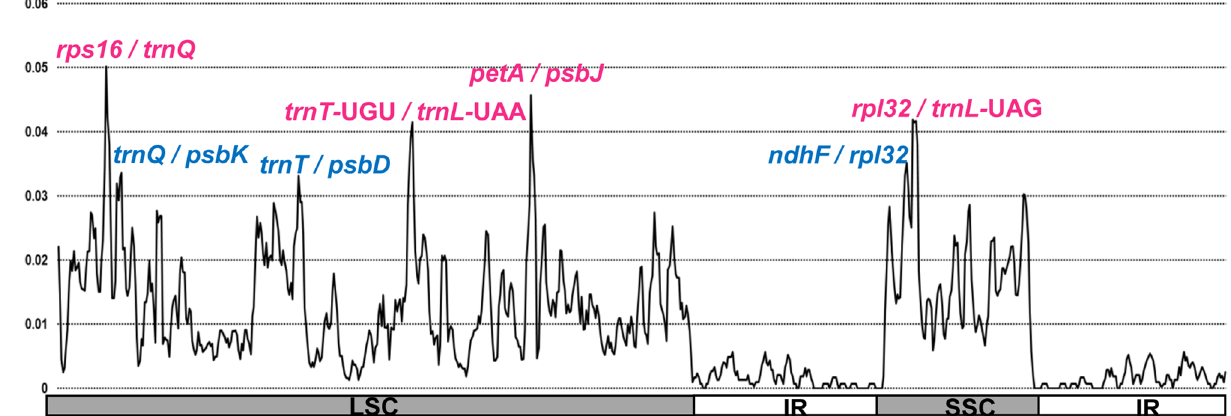
Figure 5. Sliding window analysis of the eight whole chloroplast genomes of Rubus species in Taiwan. X-axis: position of the window midpoint, Y-axis: nucleotide diversity within each window.